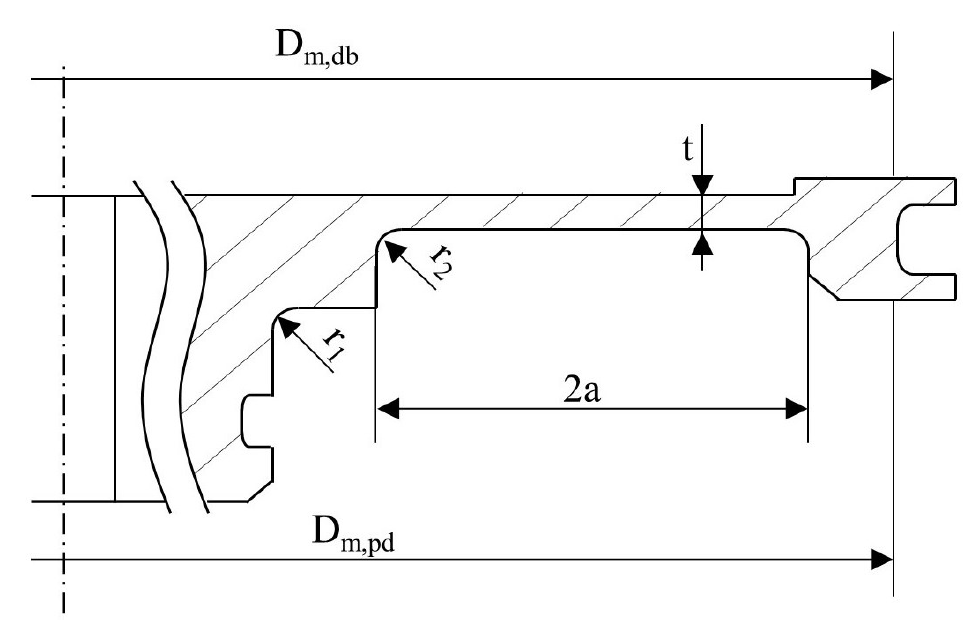
Figure 2. Schematic representation of the most relevant dimensions of the